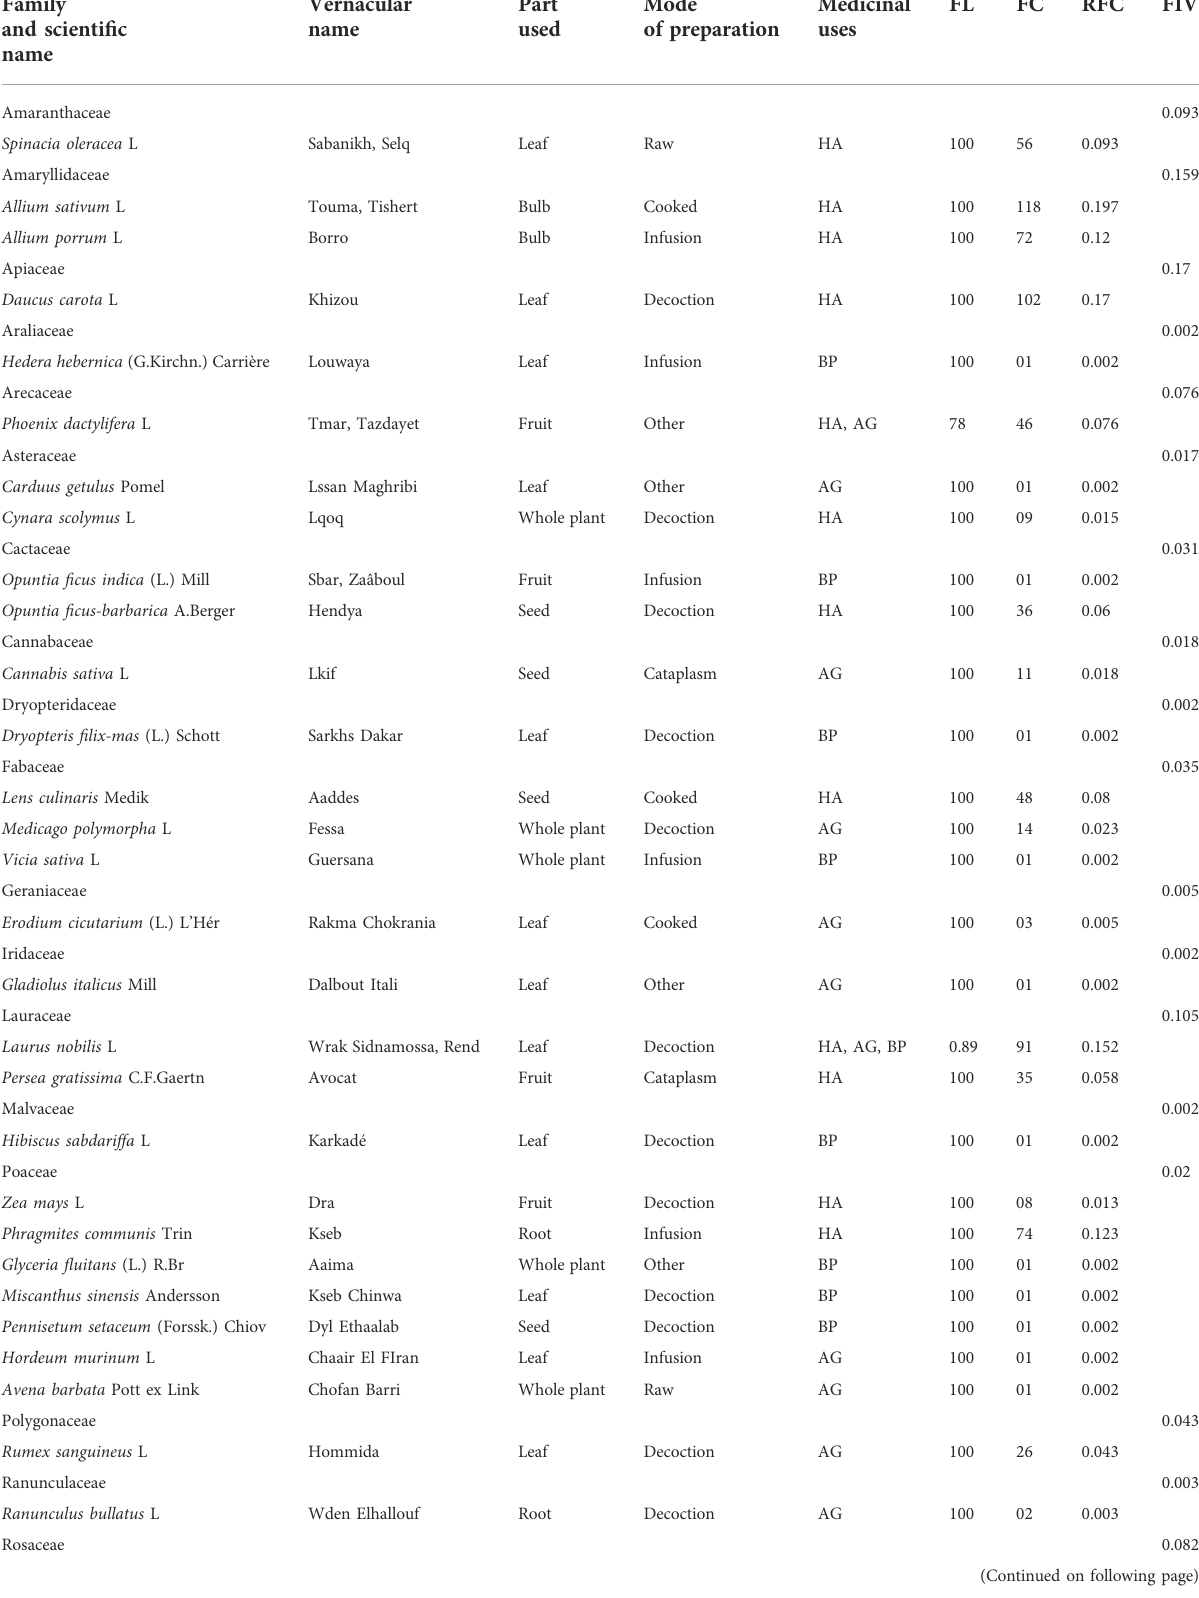
TABLE 2 List of medicinal and aromatic plant actives on the cardiovascular diseases in the Moroccan Rif region. Family and scienti fi